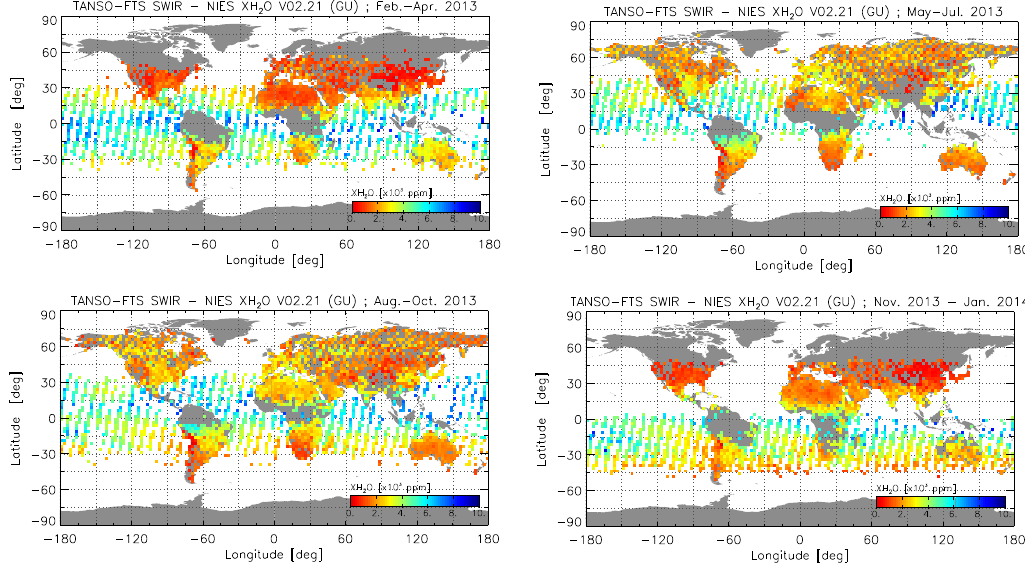
Figure 1. Three-month averages of Short-Wavelength Infrared (SWIR) measurements of column-averaged dry-air mole fractions of water vapor (XH 2 O) from the Thermal And Near-infrared Sensor for carbon Observation-Fourier Transform Spectrometer (TANSO-FTS) (National Institute for Environmental Studies (NIES) V02.21 retrievals) representative of specific seasonal patterns, for data acquired between February 2013 and January 2014. From left to right and top to bottom: around the spring equinox (February–April), the summer solstice (May–July), the fall equinox (August–October) and the winter solstice (November–January). Because the orbit is Sun-synchronous, the band in which sunglint (specular reflection) ocean measurements are possible is located at different latitudes depending on the period. Data are averaged for each period and binned using a latitude/longitude mesh of 2.5 ◦ × 2.5 ◦